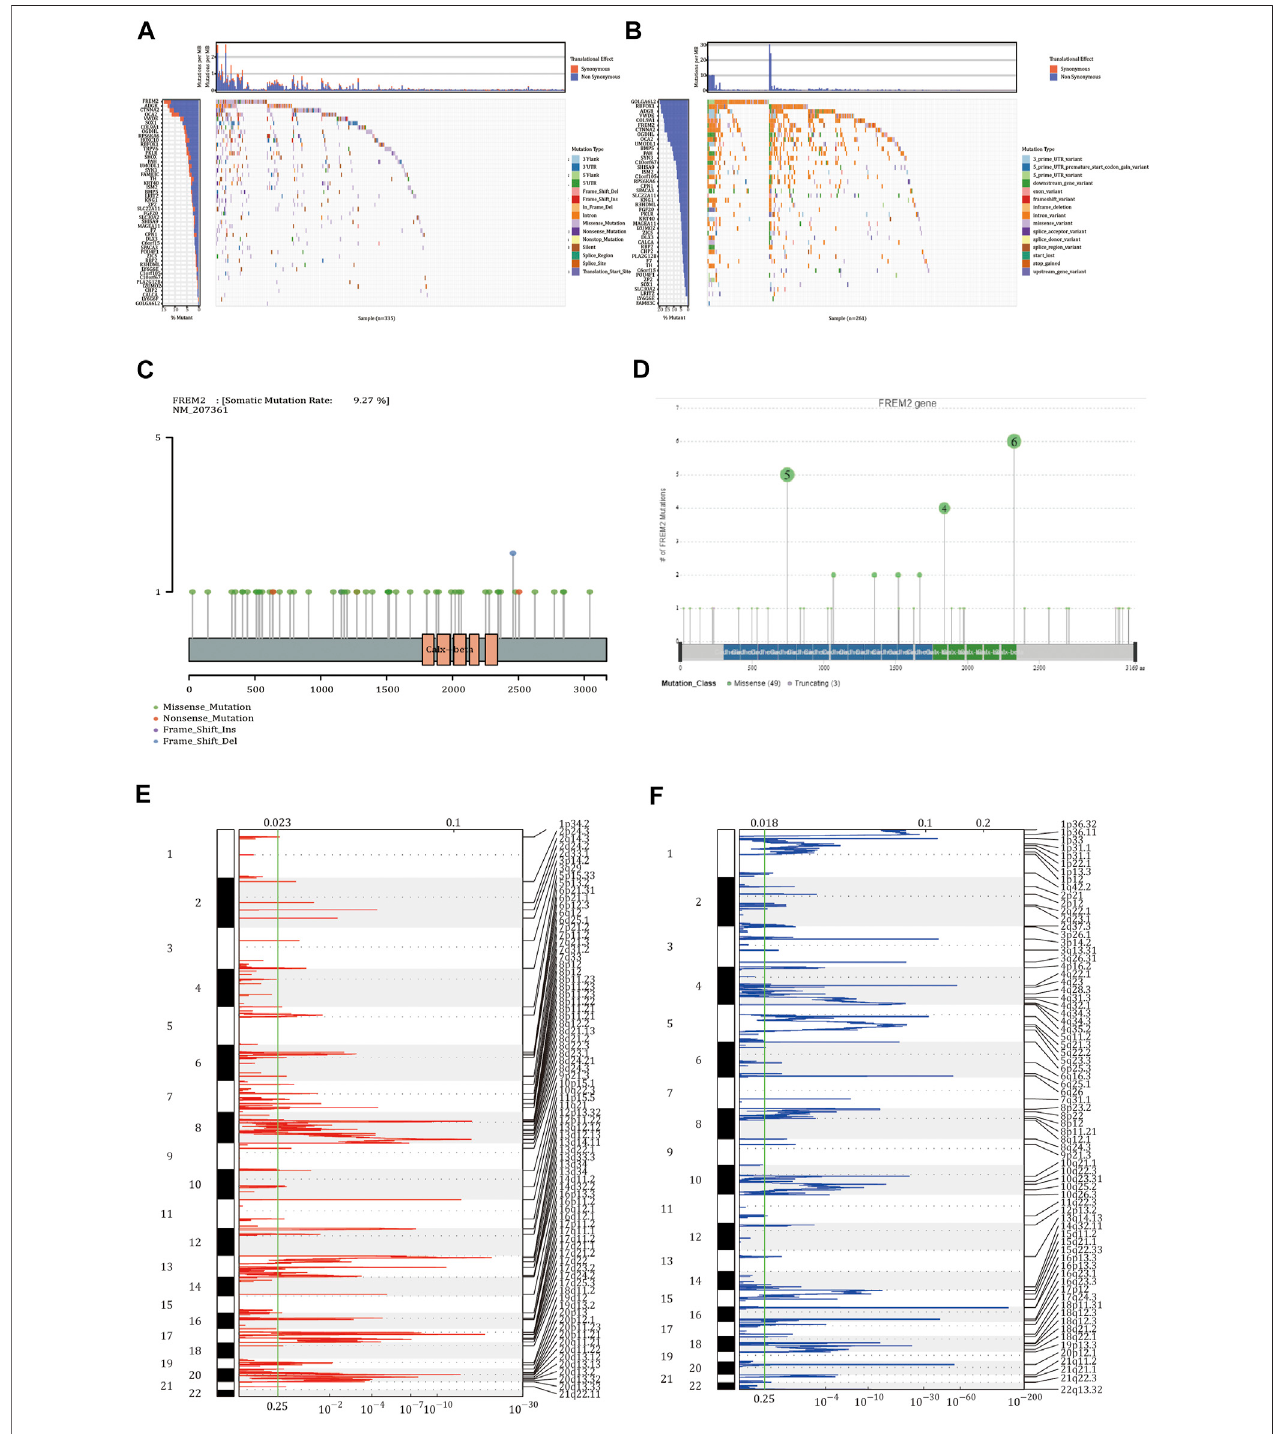
FIGURE1| Somaticmutationandcopynumbervariationanalysisincolonadenocarcinoma(COAD)patients. (A) The68geneswiththehighestmutationfrequency in COAD patients from The Cancer Genome Atlas (TCGA). (B) The mutations of 68 genes in the International Cancer Genome Consortium (ICGC) database. In the two waterfall charts, the left panel shown genes with high frequency mutations arranged according to their mutation frequency and the right panel shows different types of mutationsrepresented byvarious colormodules. (C) Themutationsof FREM2 inTCGAcohortand (D) intheICGCcohort. (E , F) Identi fi cationtheampli fi cationand deletion of FREM2 . The mRNA located at the focal copy number alteration peak was related to COAD. The false discovery rate (Q value) and the change score of GISTIC2.0( x -axis)correspondtothepositionofthegenome( y -axis).Thedottedlineindicatesthecentromere. Thegreenlinerepresentsthe0.25Qvaluecutoffpointfor determining signi fi